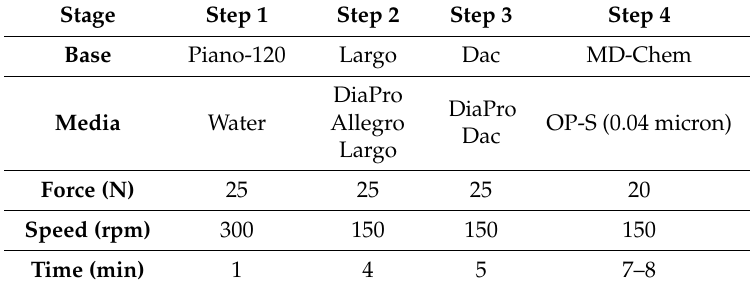
Figure 1. Experimental procedure for melt track measurements for both height and width.